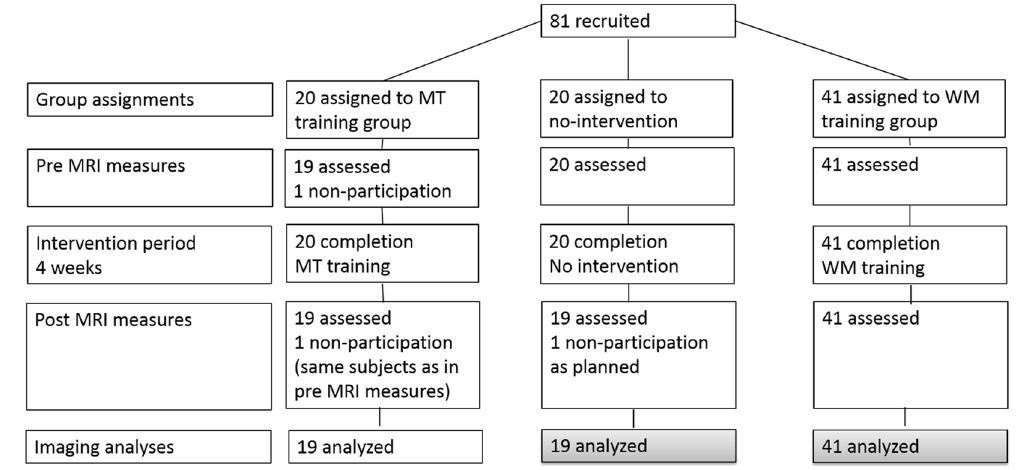
Figure 1. Flow of participants through the study. The data of gray parts was analyzed in this